Question: In a single sentence, describe what this figure presents.
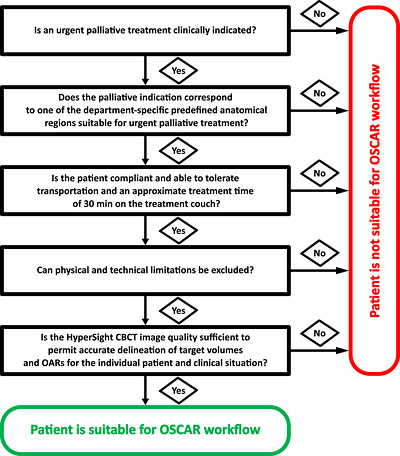
Answer: Individual steps for guiding the physician deciding whether the OSCAR workflow is applicable.